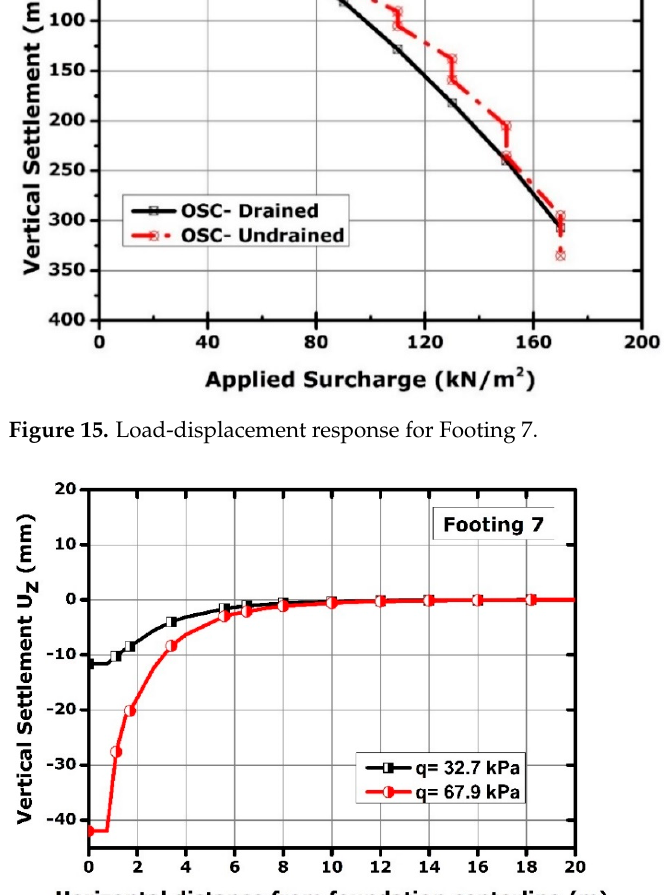
Figure 15. Load-displacement response for Footing 7.